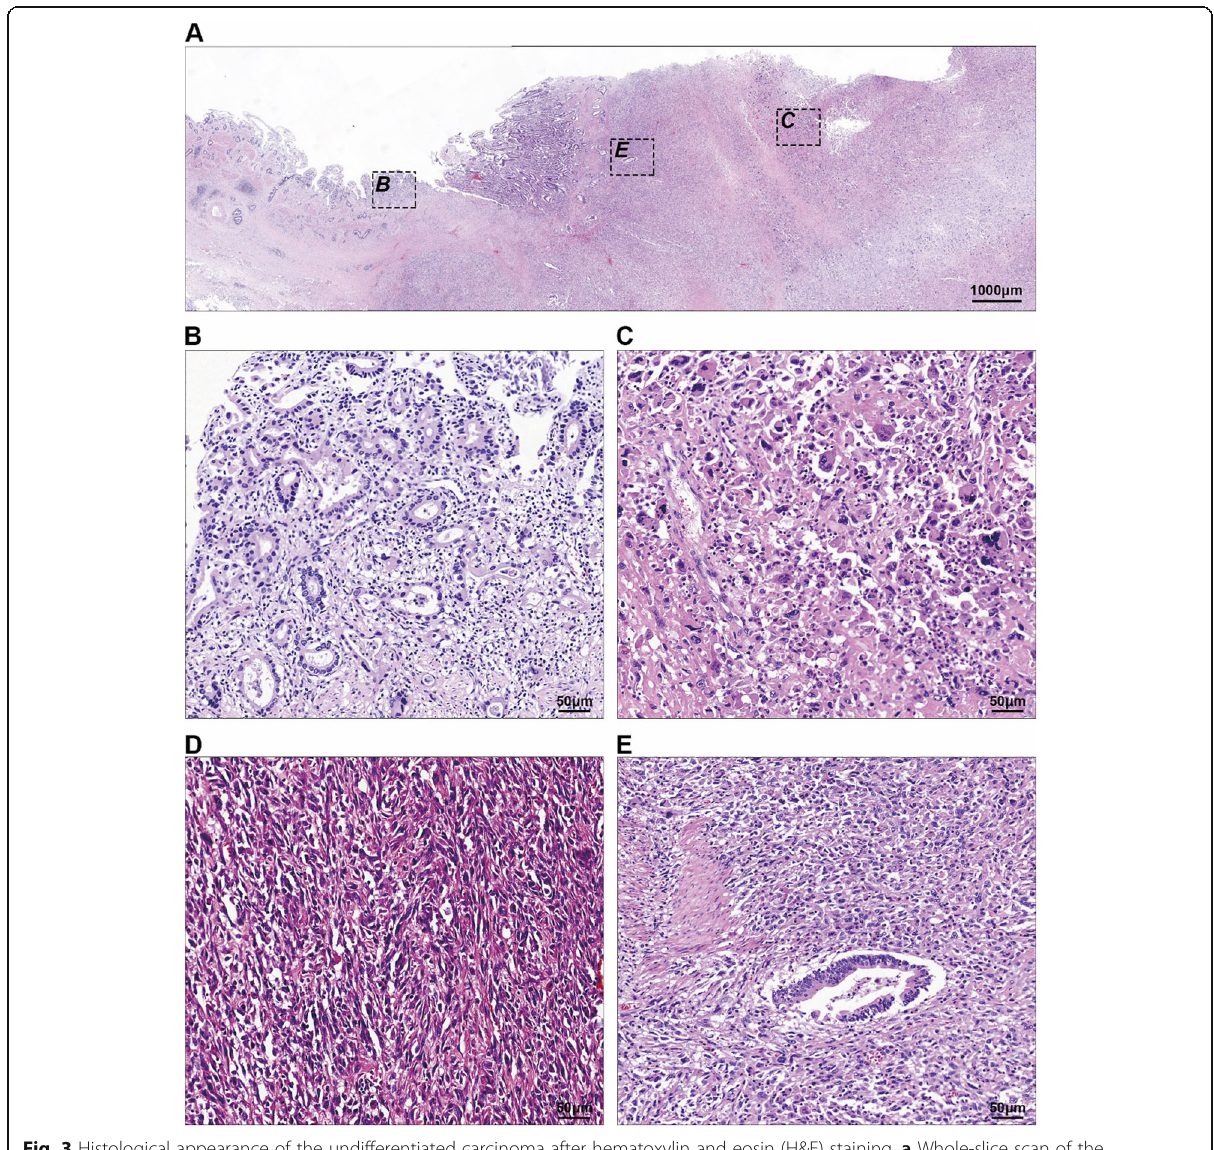
Fig. 3 Histological appearance of the undifferentiated carcinoma after hematoxylin and eosin (H&E) staining. a Whole-slice scan of the corresponding black dotted box in Fig. 2b. b Tubular pattern of the tumor corresponding to the “ b ” black dotted box in Fig. 3a. c Undifferentiated pattern with pleomorphic mononuclear cells of the tumor corresponding to the “ c ” black dotted box in Fig. 3a. d Undifferentiated pattern with spindle cells of the tumor (not included in Fig. 3a). e The transition part of the tumor corresponding to the “ e ” black dotted box in Fig. 3a. Original magnification: × 10 ( a ); × 200 ( b-d